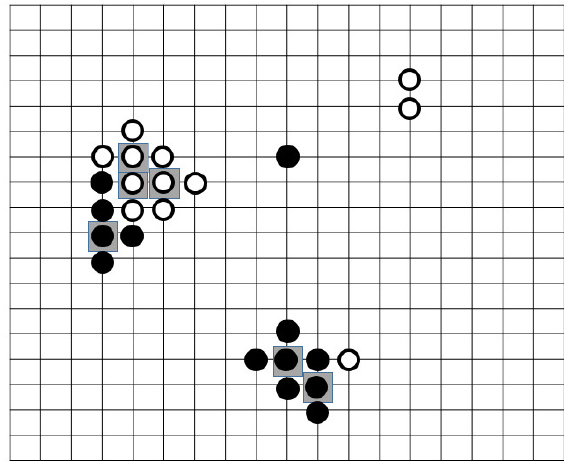
Figure 5: A configuration of the Go game after several moves (payoffs defined on the basis of the VPRSM approach for β = 0 . 25 )